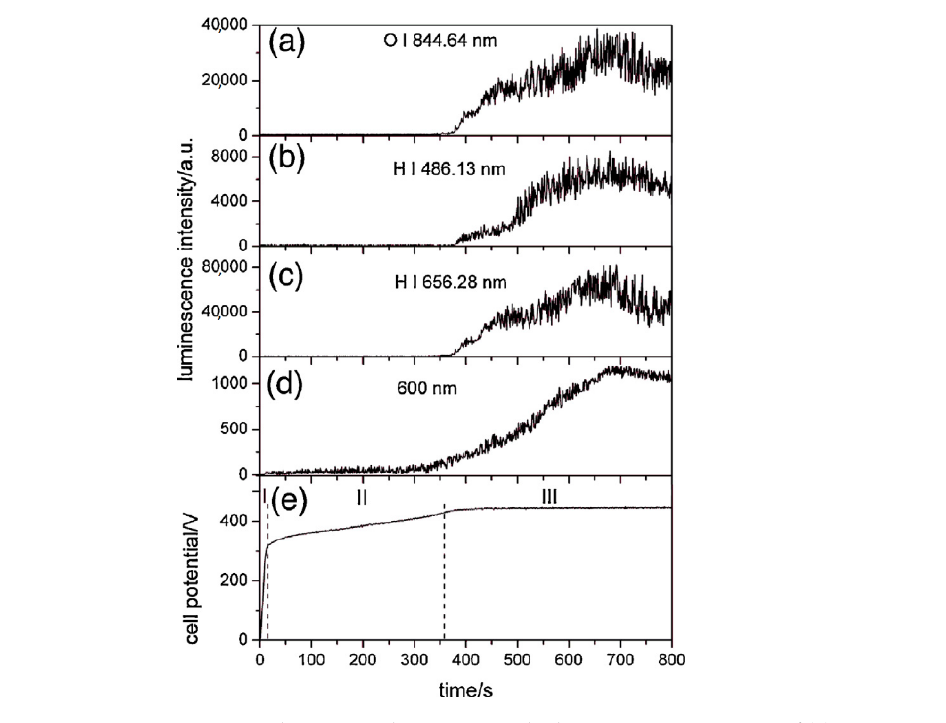
Figure 4. The temporal variation in the luminescence intensity of ( a ) oxygen and ( b , c ) hydrogen lines, ( d ) continuum radiation at 600 nm, and ( e ) cell potential. Adapted with permission from Ref. [61]. Copyright 2015 Elsevier.